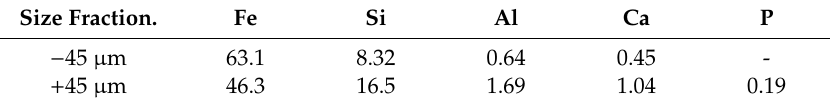
Figure 7. Metallurgical balance for Flowsheet 1 with a feed particle size of P 80 = 45 μm. Table 3. The major element in the products from the classification unit. Size Fraction. Fe Si